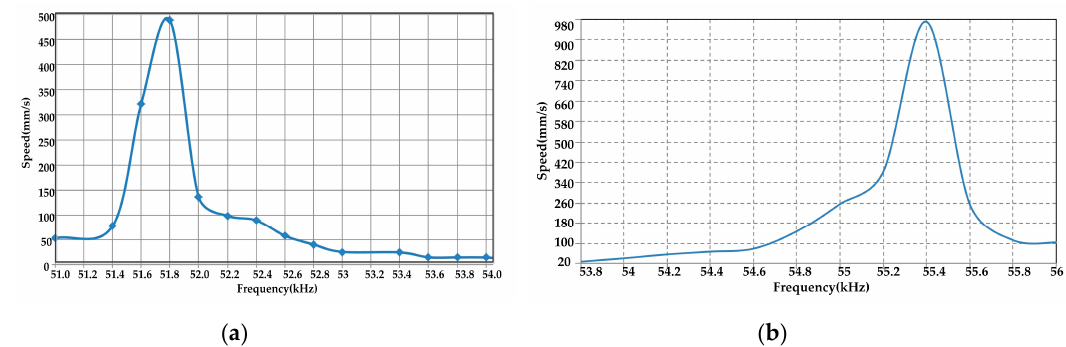
Figure 17. Frequency speed curve: ( a ) Frequency speed curve with single-phase excitation; ( b ) frequency speed curve with dual-phase excitation.